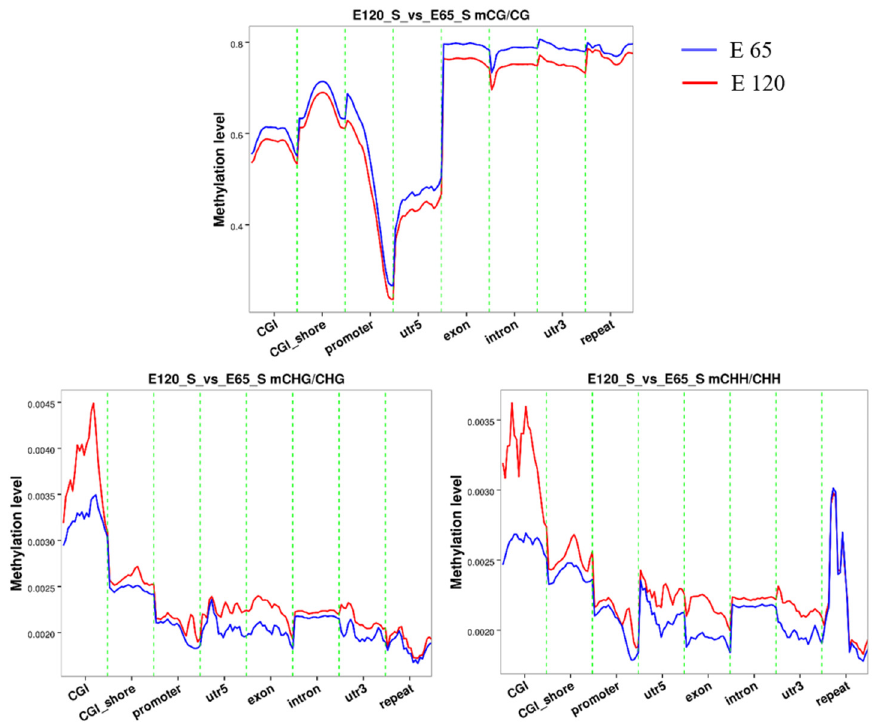
Figure 8. The methylation level in different gene regions for mCG, mCHH, and mCHG. At the genome-wide scale, the E 65 samples exhibited a higher CG methylation status in all regions. Marked hypomethylation was observed in the regions surrounding the transcription start site.